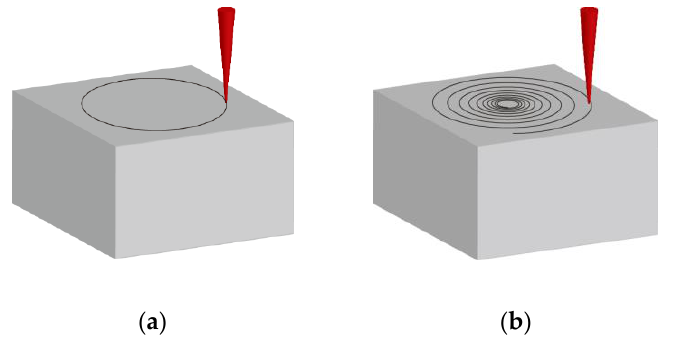
Figure 2. ( a ) Circular laser drilling trajectories and ( b ) spiral laser drilling trajectories.